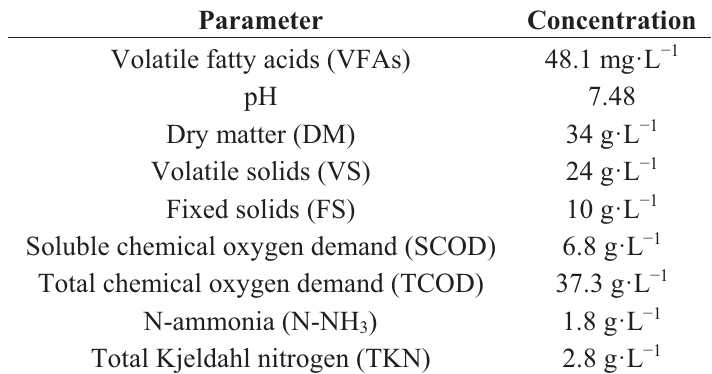
Table 2. The physico-chemical characteristics of storage tank residual